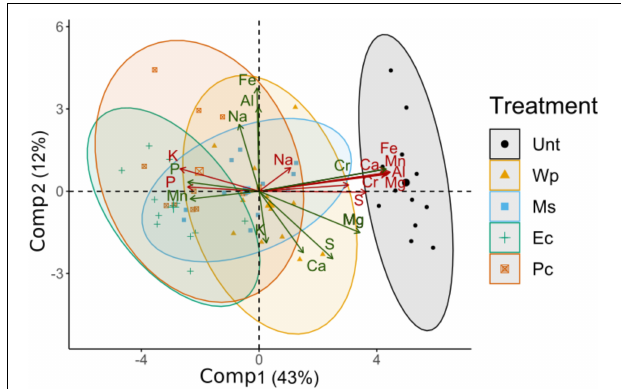
FIGURE 5 | Principal component analysis (PCA) of the concentrations of elements determined in leaves (green) and the total concentrations of elements determined in the substrates at T0 (red). The largest symbols in the graphic represent the barycenter of each treatment. Ellipses represent the confidence intervals at 95%.